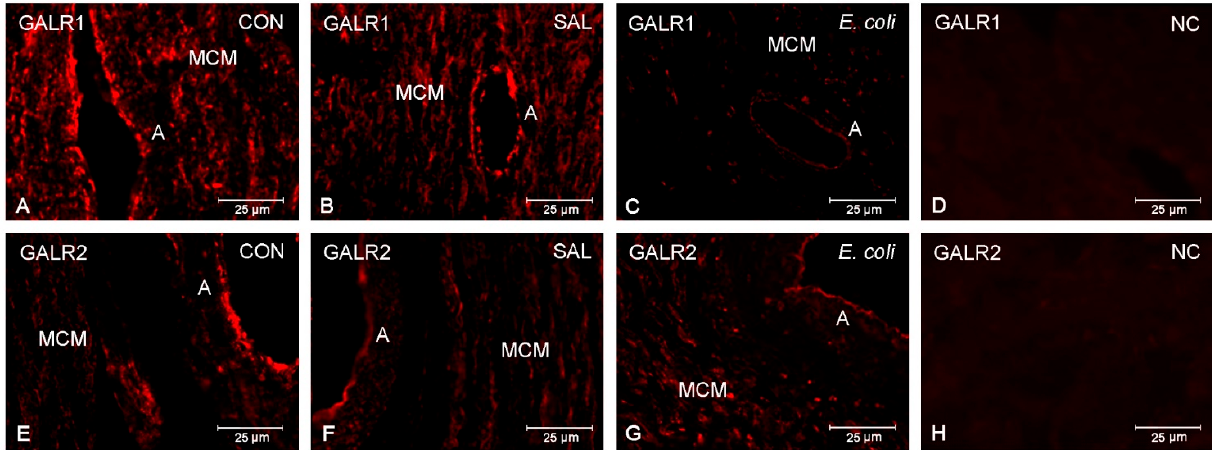
Figure 2. The pictures present GALR1 ( A – C ) and GALR2 ( E – G ) in the myometrial layer of gilts from the control (CON), saline (SAL), and E. coli groups. Positive immunoreaction to GALR1 was found in muscle cells, as well as in arteries (endothelium, muscle layer) of myometrium, of the control ( A ), saline-injected ( B ), and inflammatory-changed ( C ) uteri. Similarly, GALR2 was expressed in these structures in the control ( E ), saline-injected ( F ), and inflamed ( G ) organs. Negative control (NC) for GALR1 ( D ) and GALR2 ( H ) was obtained following the use of normal rabbit IgG instead of the primary antibodies. MCM—myometrial muscle cells; A—artery.